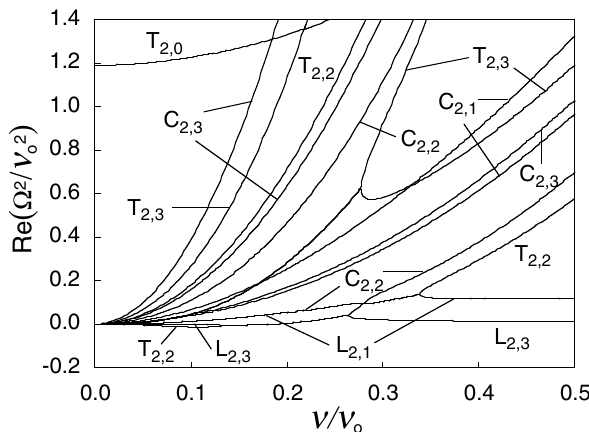
FIG. 11. The real part of (cid:13) 2 =(cid:10) 2 modes as a function of (cid:10)=(cid:10) wall impedance.